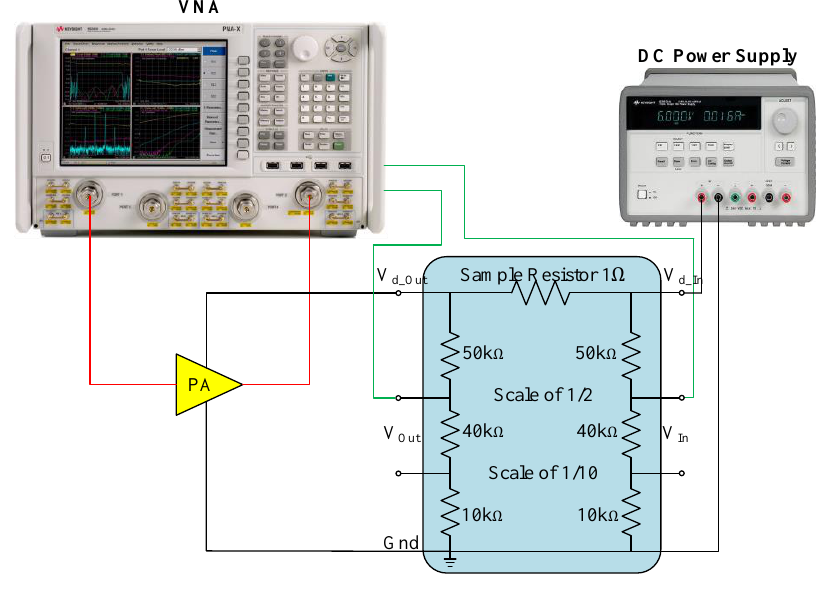
Figure 8. Traditional VNA PAE test plan.